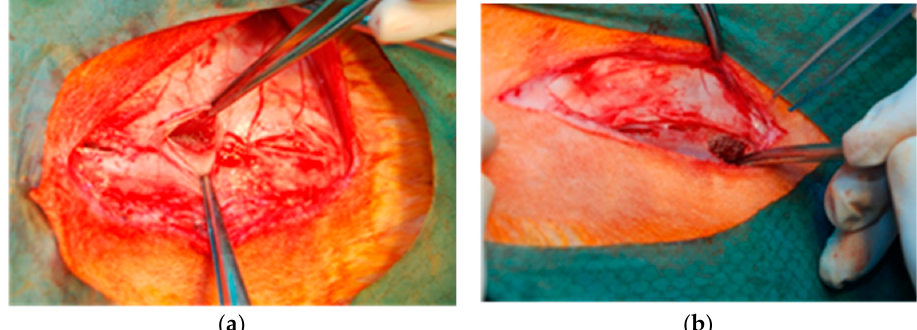
Figure 3. Intrasurgical photography: implantation of samples into pockets in the dorsal muscles of an NZW rabbit. The evaluated samples are localized on the left ( a ), and the reference on the right side of the spine ( b ).